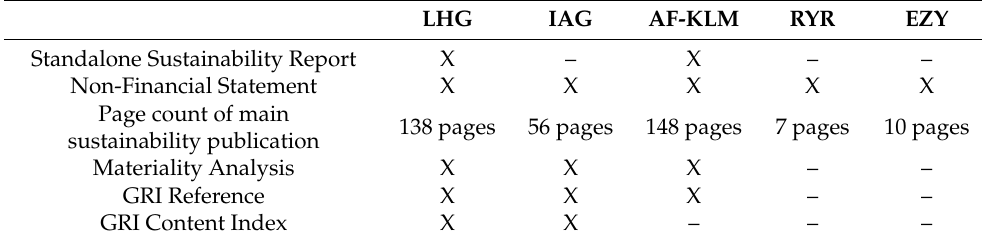
Table 2. Differences in Reporting Approaches and Formats.